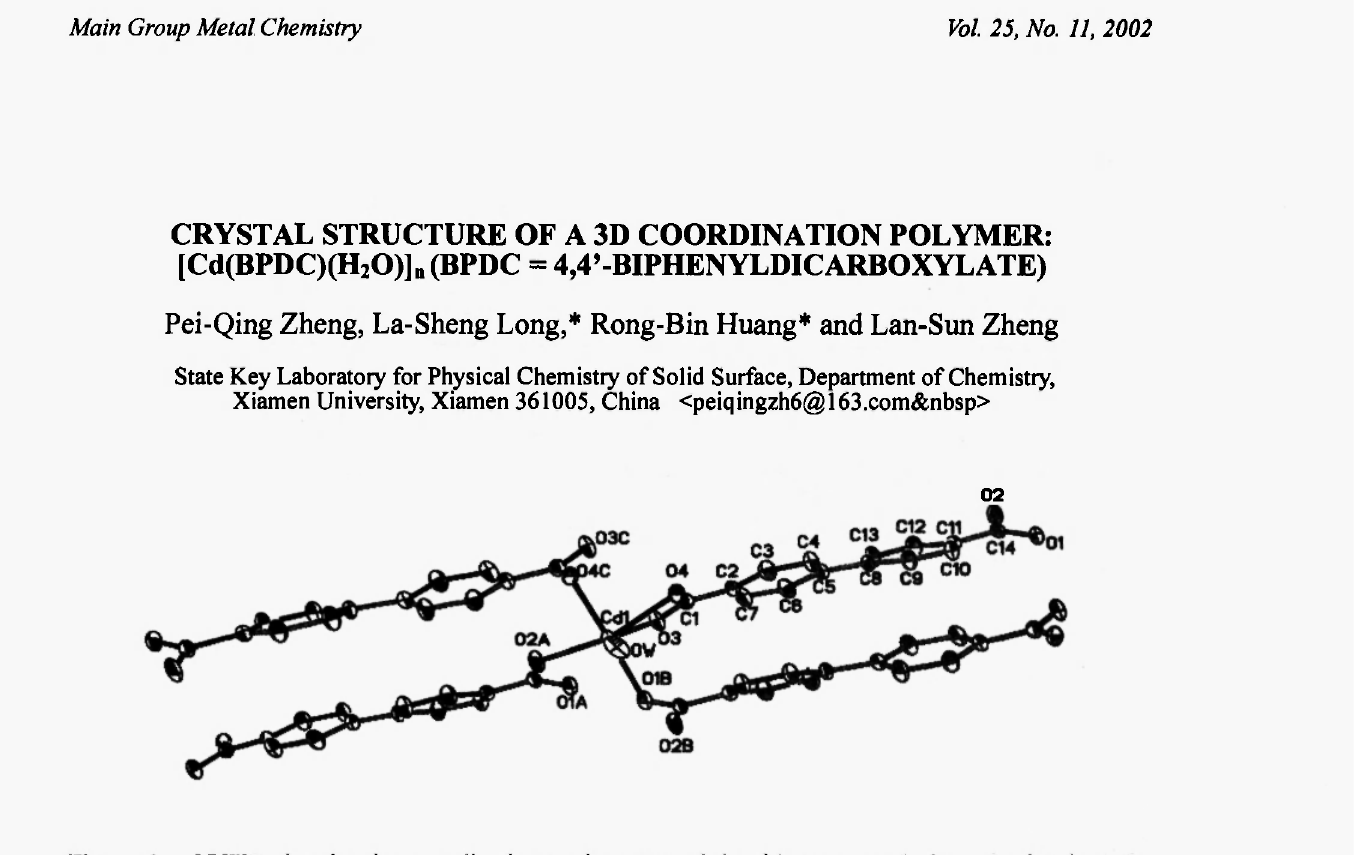
Figure 1. ORTEP plot showing coordination environment of the title compound along the i-axis at the 50% probability level. Selected bond distance and angles: Cdl-03 = 2.336(3), Cdl-04 = 2.405(3), Cdl-Ow = 2.263(3), Cdl-01 b = 2.331(3), Cdl-02 a = 2.182(3), Cdl-04 c = 2.418(3) A; 02'-Cdl-0w = 104.23(13), 02 a -Cdl-01 b